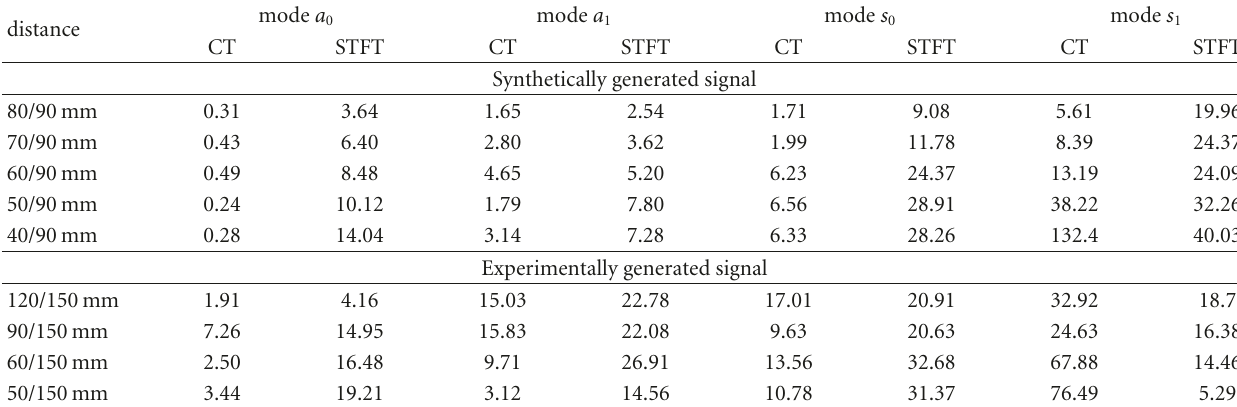
Table 2: Average deviation in % from theoretical geometric